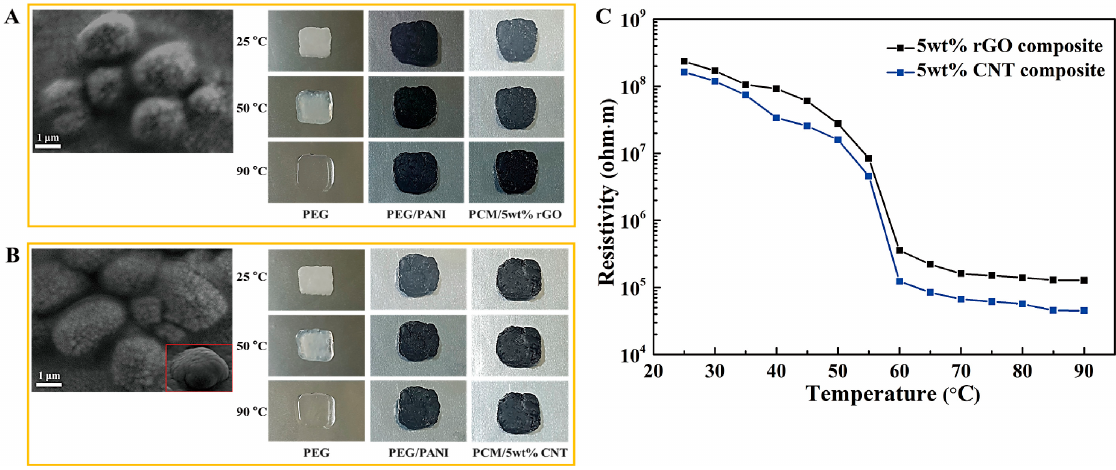
Figure 4. ( A ) PANI supported rGO/PEG composite, and ( B ) PANI supported CNT/PEG composite. ( C ) Variation of electrical resistivity under the change of